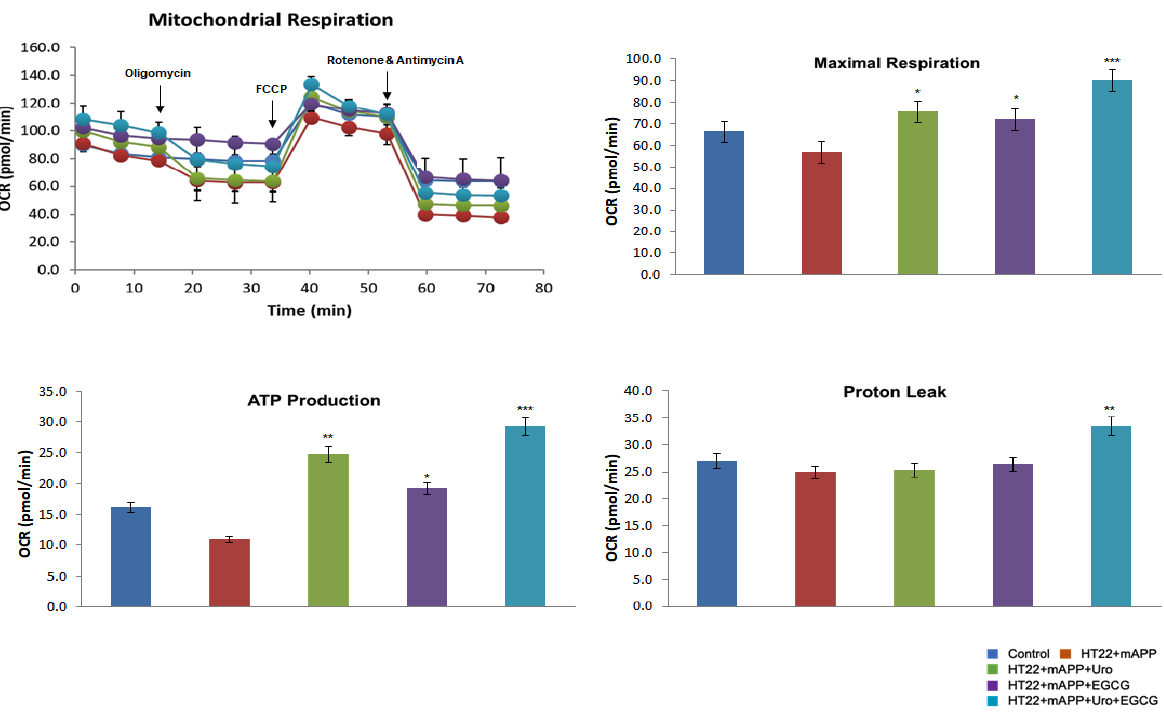
Figure 1. Urolithin A, EGCG and a combination of urolithin A+EGCG . The mitochondrial respiration was evaluated using Seahorse Bioanalyzer in HT22 cells transfected with mutant APP cDNA and treated with urolithin A, EGCG and a combination of both urolithin A+EGCG. The maximal OCR was reduced in muantAPPHT22 cells in comparison to HT22 cells. On the contrary, OCR was increased in mAPPHT22 cells treated with urolithin A, EGCG and a combination of urolithin A+EGCG compared to untreated mAPPHT22 cells. * p < 0.05; ** p < 0.01; *** p < 0.001.